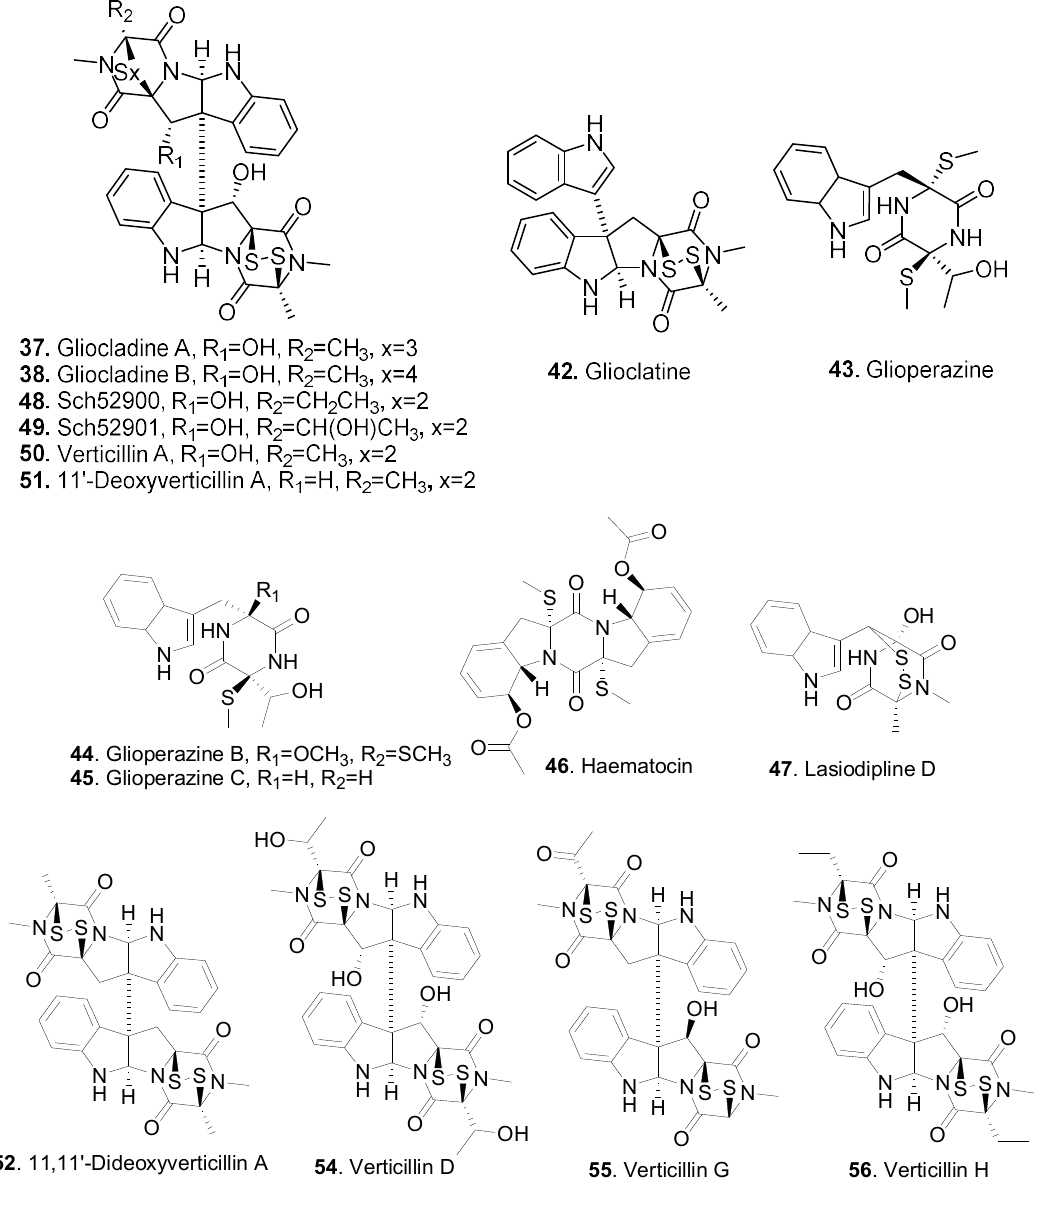
Figure 3. Piperazines isolated from Clonostachys fungi.